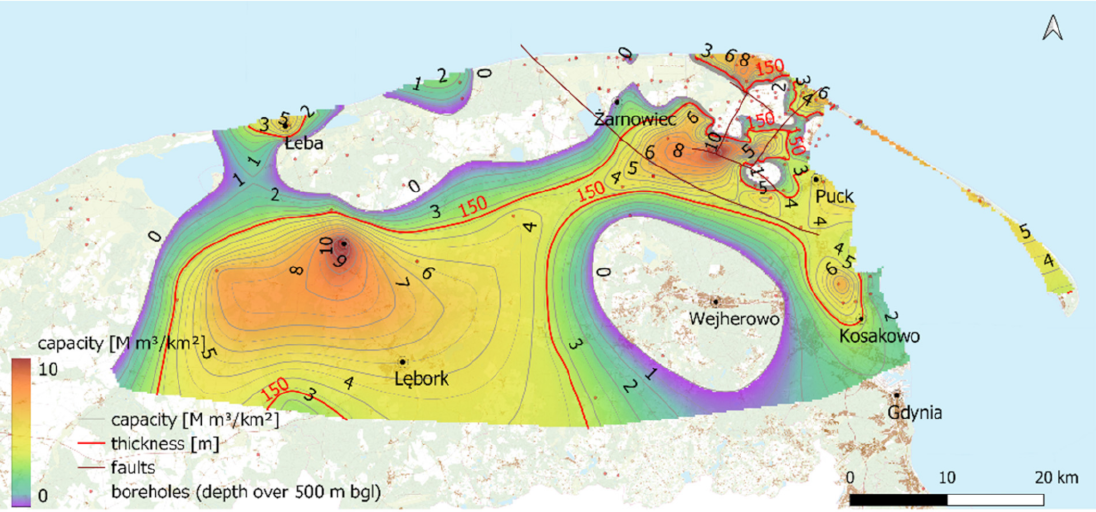
Figure 6. The storage capacity of liquid fuels in the rock salt layer in northern Poland, strategic caverns.